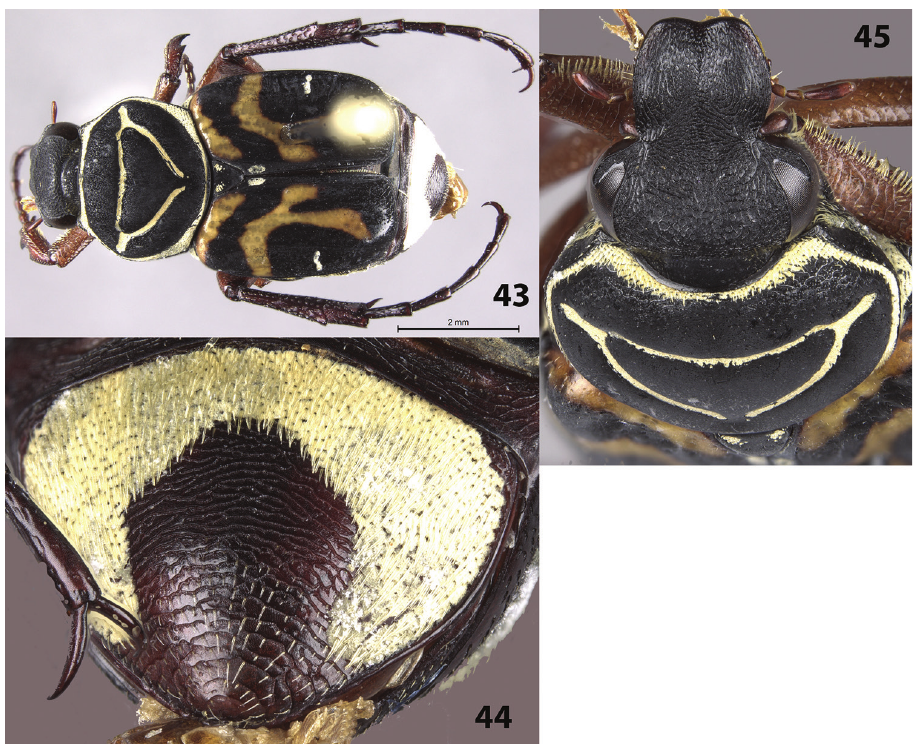
Figures 43–45. Trigonopeltastes warneri sp. n., female allotype. 43 Dorsal view of habitus 44 Pygidium 45 Head and